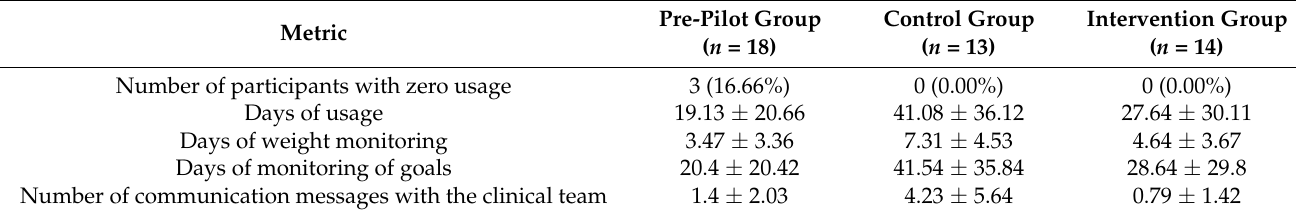
Table 3. Usage metrics of the ENDORSE parental mobile